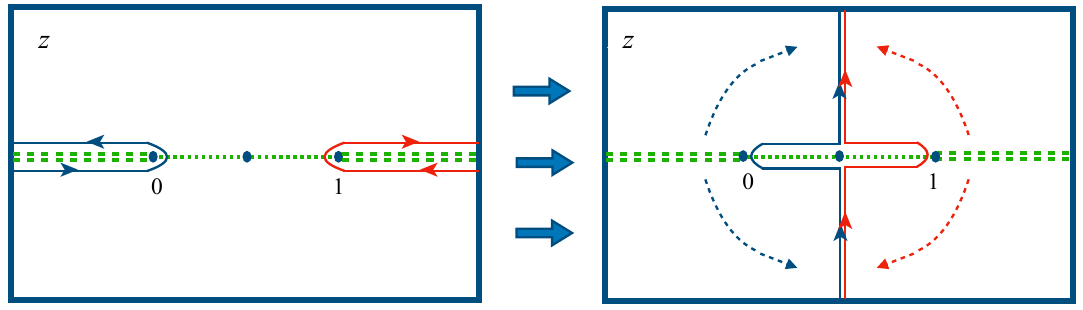
Figure 1 . Contour deformation leading from (3.5) to